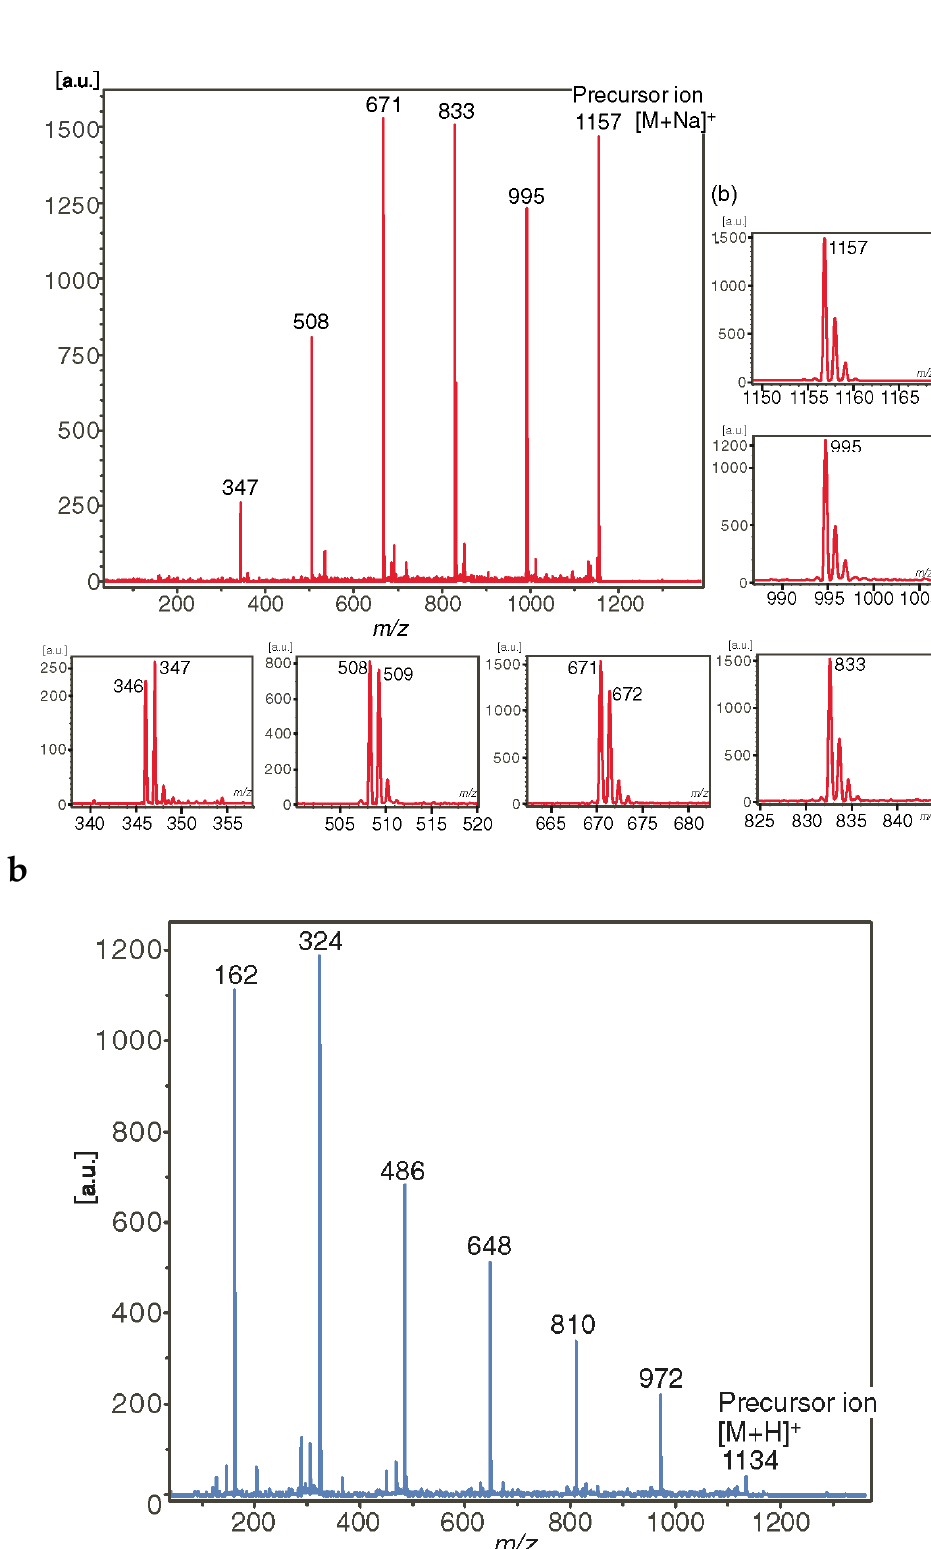
Figure 8. LID MALDI TOF / TOF MS of ions generated from 7 . ( a ) MS 2 of [M + Na] + ion, extensions of